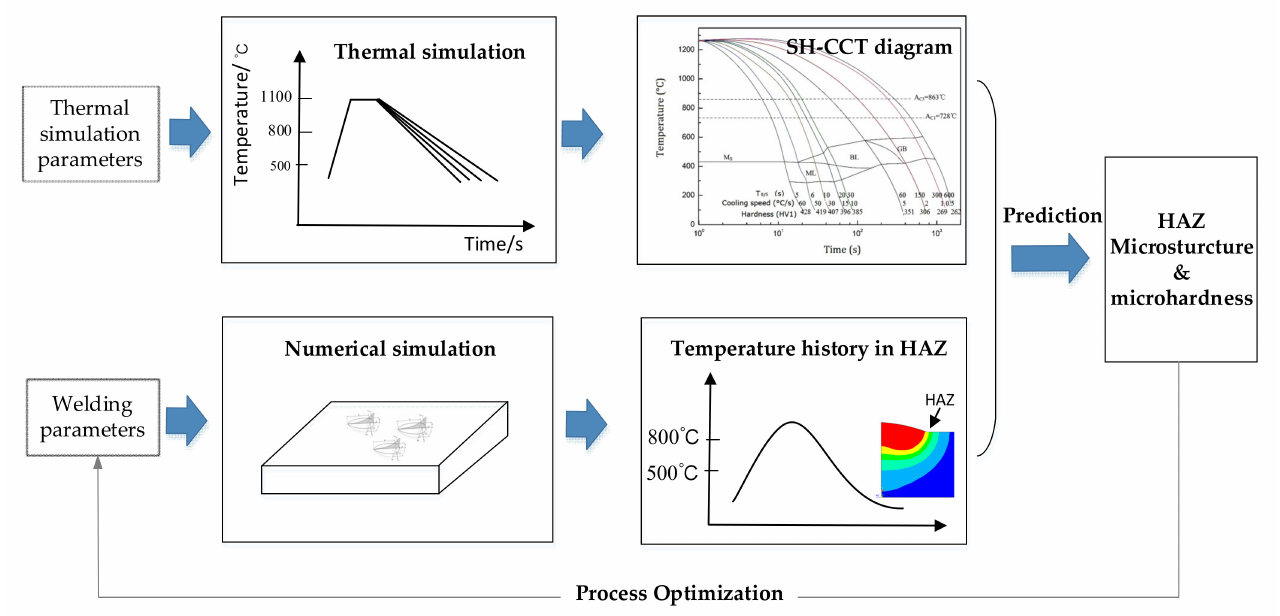
Figure 3. Schematic diagram of the prediction of the HAZ microstructure and microhardness for Q960E joints welded by the triple-wire GMAW process.